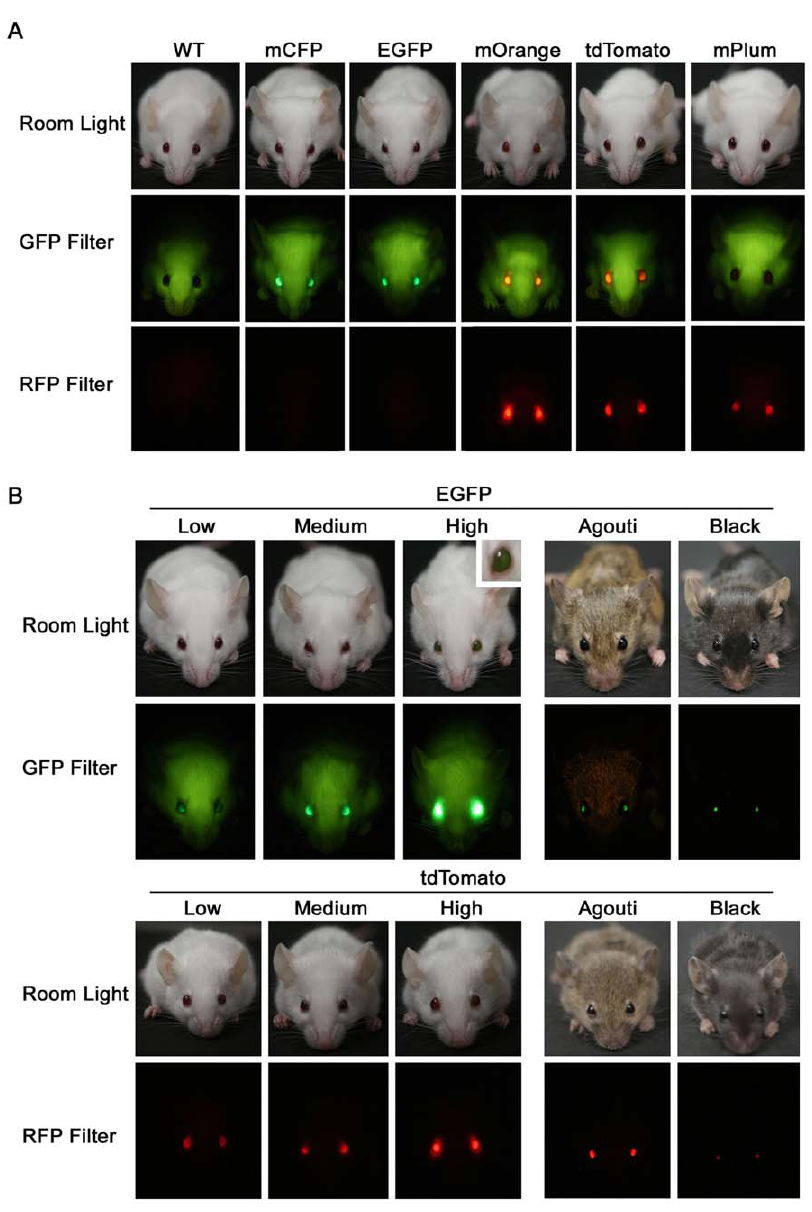
Figure 2. Fluorescent eye marker visibility and variability. (A) Fluorescent proteins expressed in the lens can be visualized under a handheld flashlight. All five fluorescent eye markers can be seen using the GFP flashlight while only mOrange, tdTomato, and mPlum can be seen using the RFP flashlight. (B) EGFP and tdTomato marker expression varies between transgenic lines (Low, Medium, High). Inset shows EGFP ‘‘high’’ line is visible in room light with no excitation. EGFP ‘‘medium’’ and tdTomato ‘‘high’’ transgenic lines are also shown in pigmented (Agouti, Black) backgrounds. Note that the visibility of fluorescent eye markers is reduced in pigmented backgrounds.